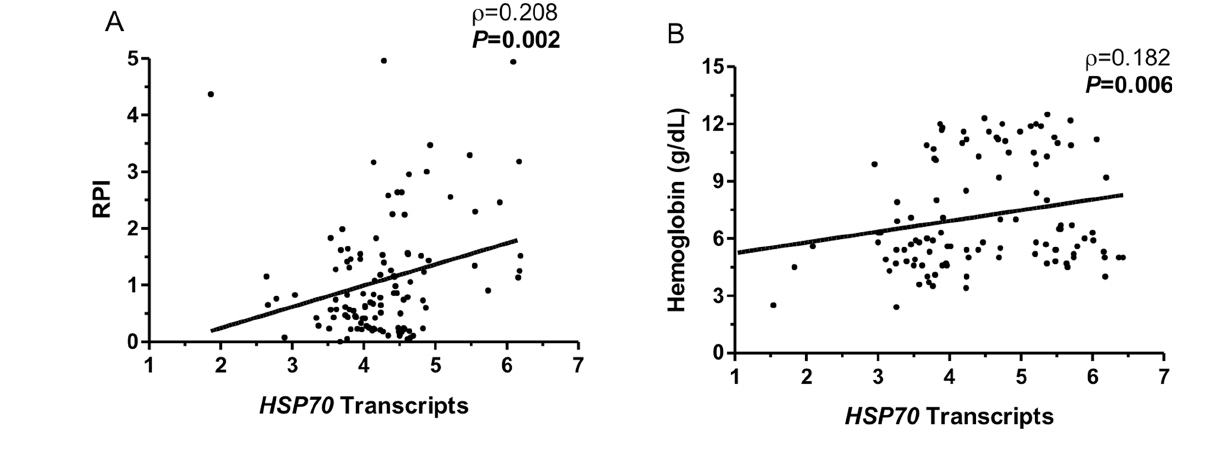
Figure 2. Relationship between HSP70 transcripts and indicators of anemia (RPI and Hb). HSP70 (1A + 1B) gene expression was measured using WBCs collected from parasitemic children (n = 73). The cyclophilin-A gene was used as an endogenous control to normalize the gene expression data in qRT-PCR assays. Nonparametric Spearman ′ s rank correlation coefficient test was used to determine the relationship between HSP70 transcripts levels and (A) reticulocyte production index (RPI) and (B) hemoglobin levels